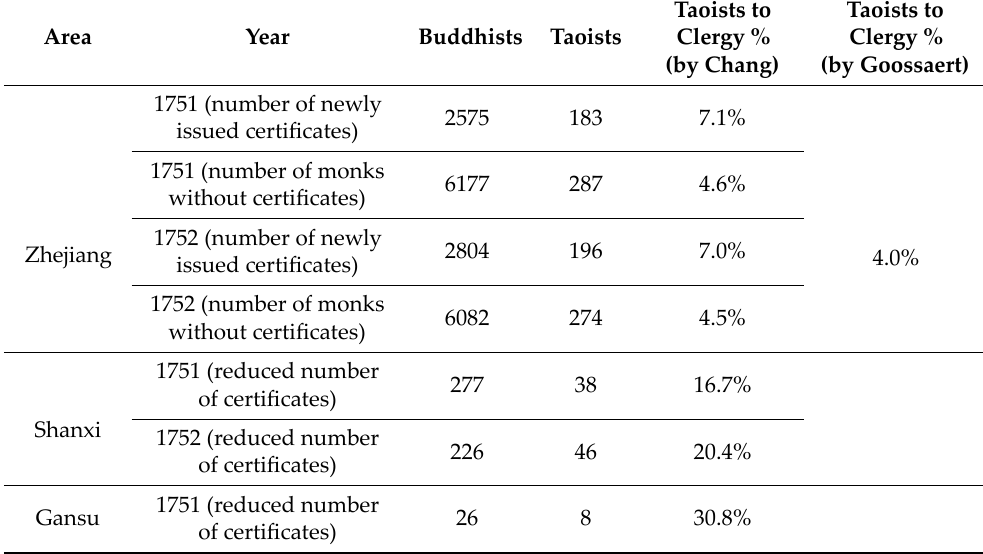
Table 7. The distribution of Buddhist temples in each province in the second half of the 18th century.